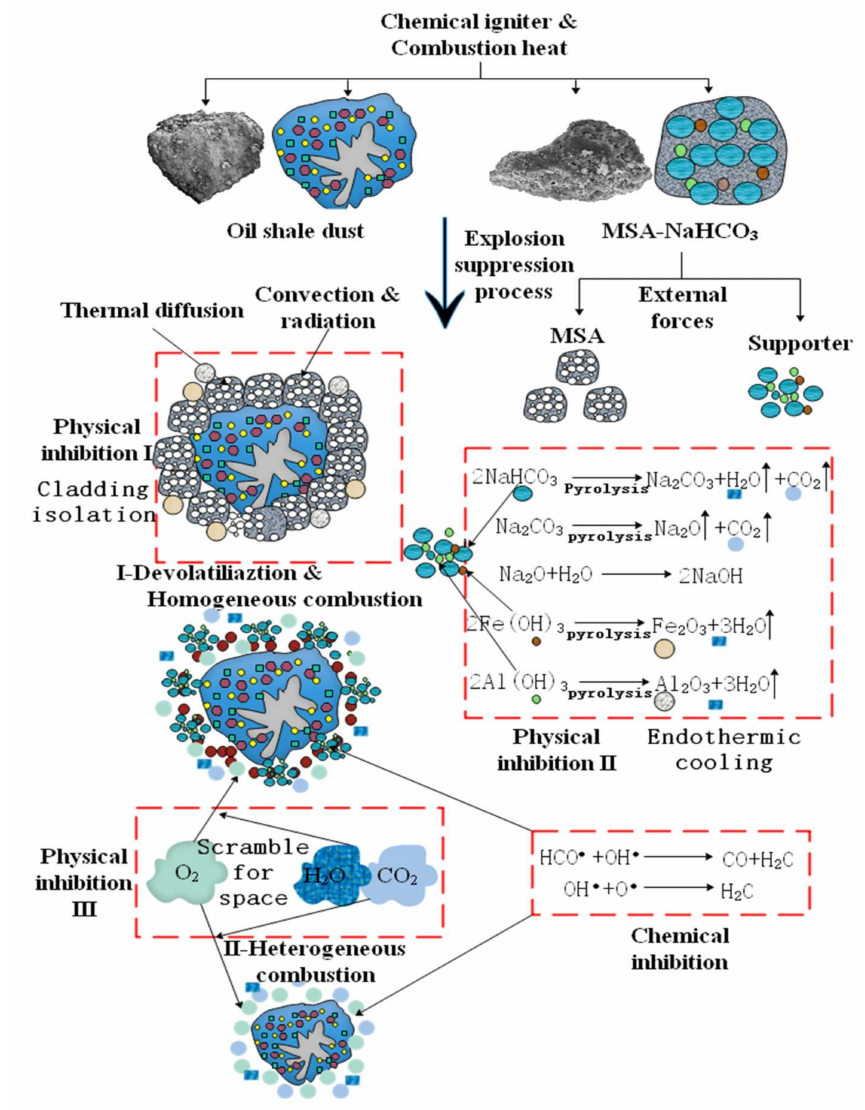
Figure 15. Schematics showing how the MSA–NaHCO 3 composite powder explosion inhibitor inhibits the explosion of oil shale